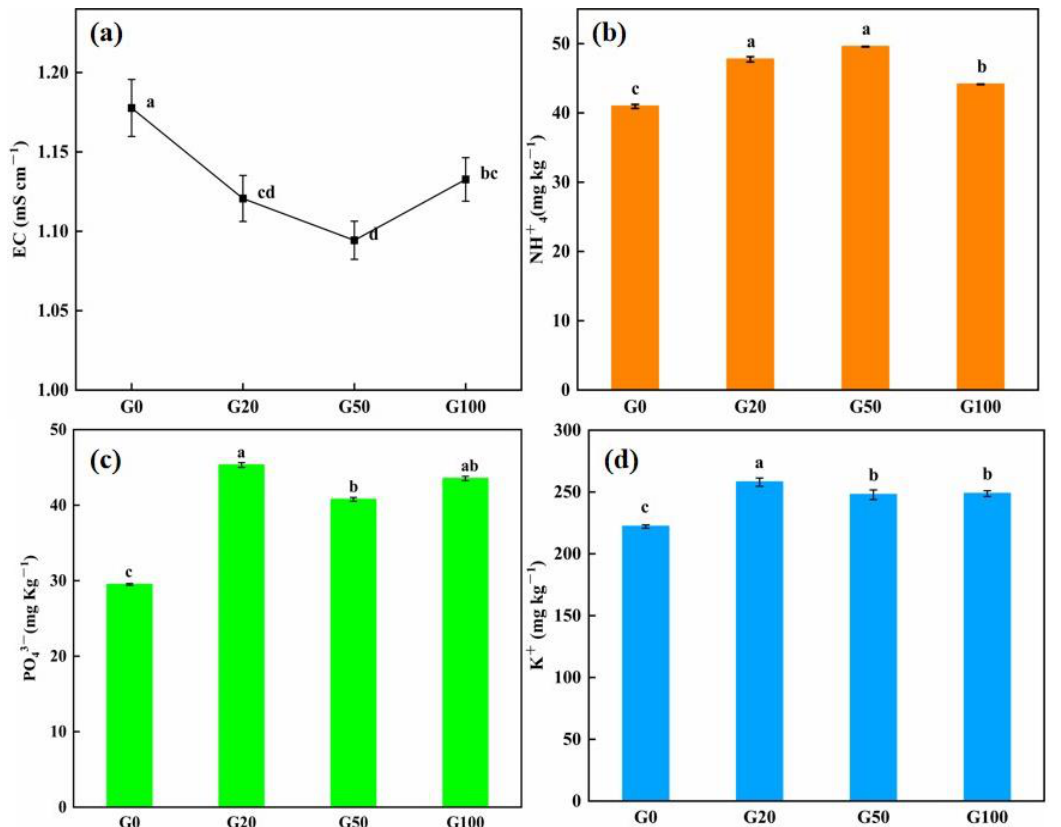
Figure 2. Effect of graphene on the content of the indicated element in soil after leaching. ( a ) Conductivity, and ( b ) NH +4 , ( c ) PO₄ 3 ⁻, and ( d ) K + content. Error bars represent the standard error of the mean (n = 5). The letters a, b, c, and d indicate statistically significant difference at p < 0.01 within each group comparison between the treatment.